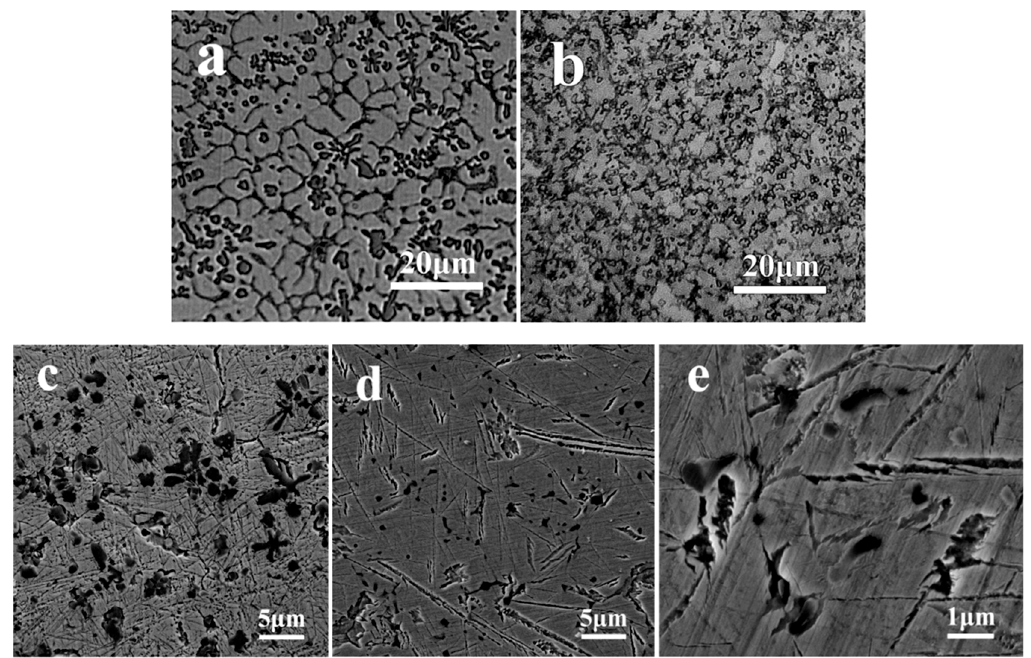
Figure 1. X-ray di ff raction patterns of cladding layers. Figure 1. X-ray diffraction patterns of cladding layers.